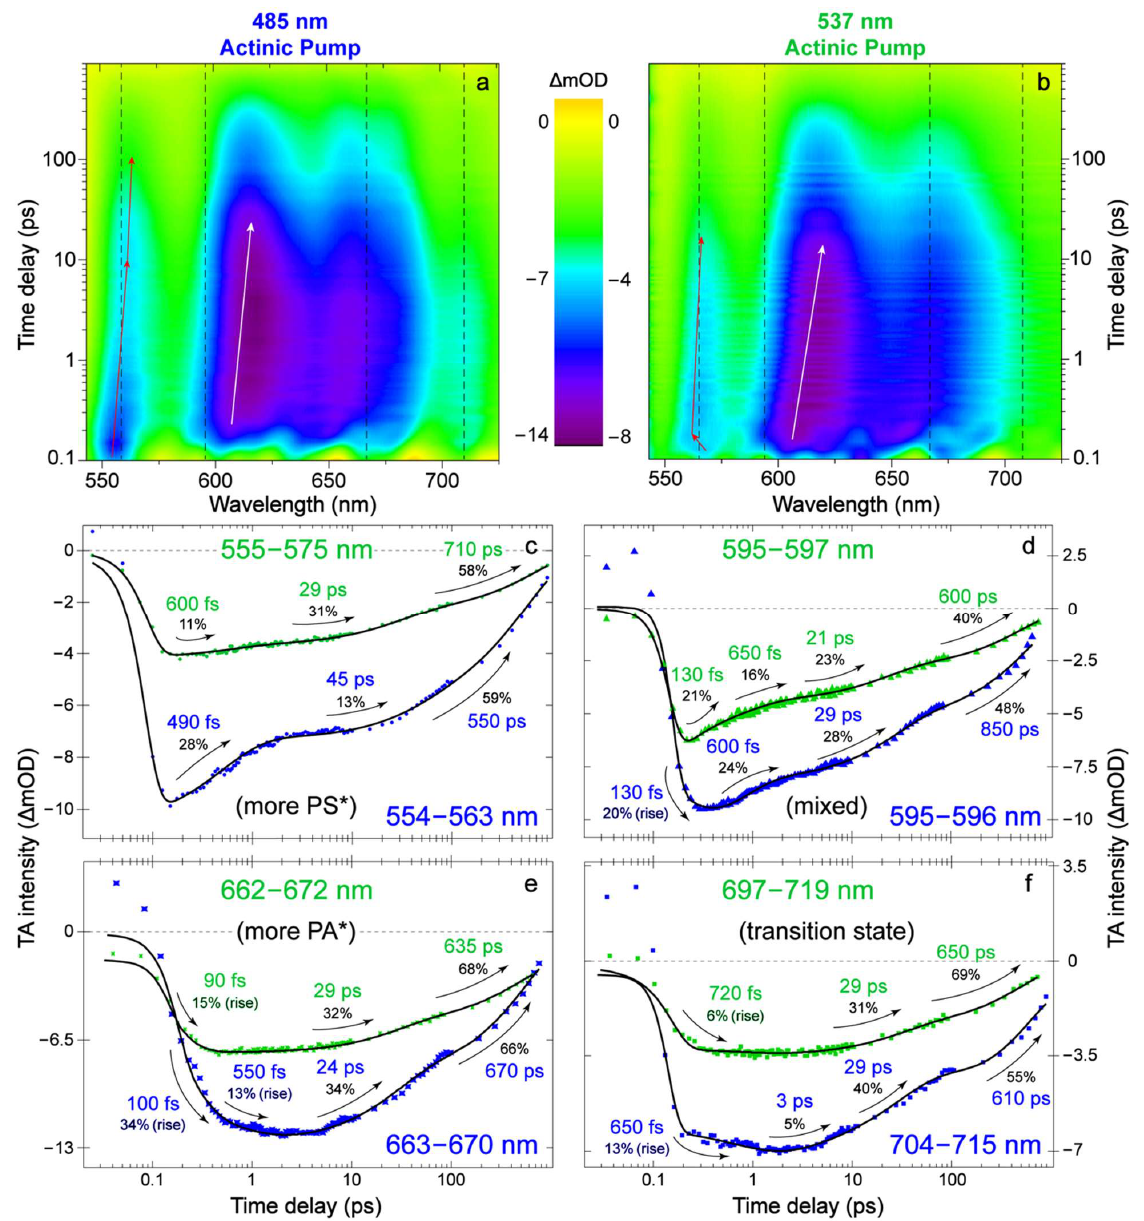
Figure 2. Transient electronic dynamics of Draconin Red in DCM solvent under two excitation conditions. Contour plots of fs-TA spectra following ( a ) 485 nm and ( b ) 537 nm excitation. Notable spectral regions of the stimulated emission (SE) bands were chosen for the probe-dependent fitting, marked by vertical dashed lines. Characteristic SE peak wavelength shifts are denoted by the titled thin red and white arrows for the minor and major SE bands, respectively. Spectral data (color-coded dots, triangles, and squares) integrated over certain regions (denoted in each panel) are overlaid with the least-squares fits (black solid curves) for the ( c ) mostly PS*-attributed blue SE band, ( d ) mixed SE band with a peak wavelength redshift, ( e ) red SE shoulder that is predicted to be mostly PA*, and ( f ) the farthest red SE band that is more pronounced after 485 nm excitation. Blue and green colors represent the 485 and 537 nm actinic pump conditions, respectively. The retrieved decay time constants and amplitude weights (summed to 100%) are listed by the best fits, with the signal intensity magnitude rise components denoted separately with their amplitude weights scaled to the summation of all the decay components. The zero-difference optical density (OD) is shown as a gray dashed line, and the TA signal intensity has the difference milli-OD ( ∆ mOD)